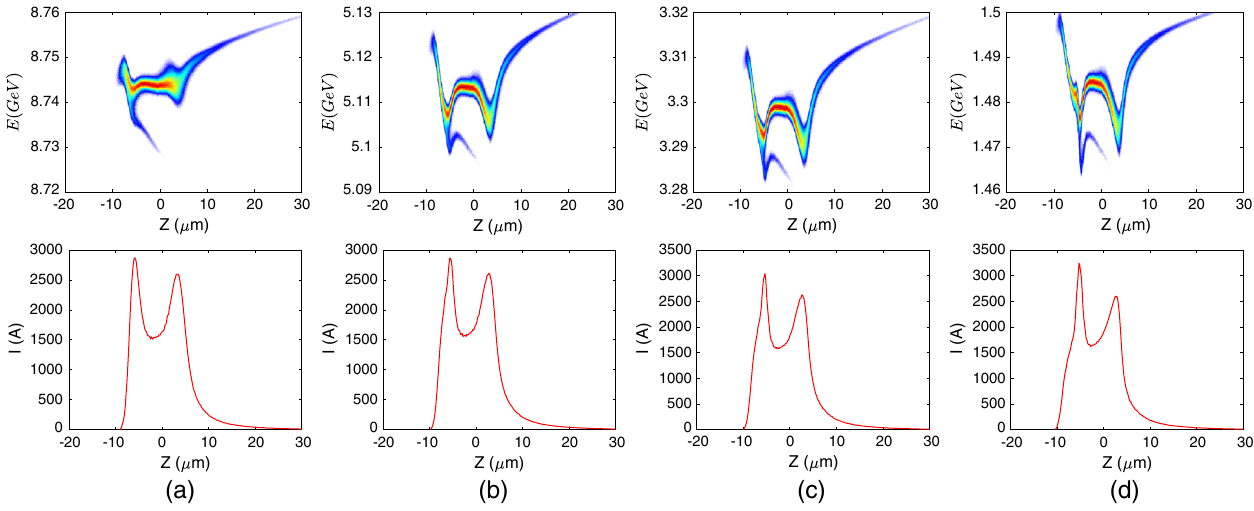
FIG. 6. Longitudinal phase spaces (upper) and current profiles (lower) of the normally accelerated electron beam (a) and the three delayed electron beams with delay distances of 57.70 (b), 76.91 (c), and 115.41 mm (d) at the end of the linac. The beams head is to the left.